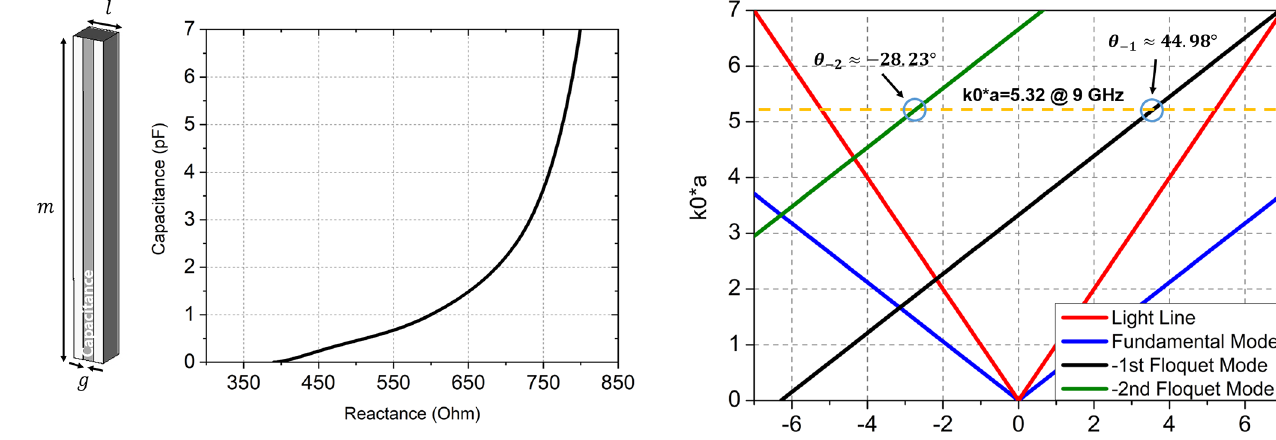
Fig. 4. A unit cell structure and the plot of surface reactance against loading capacitance.